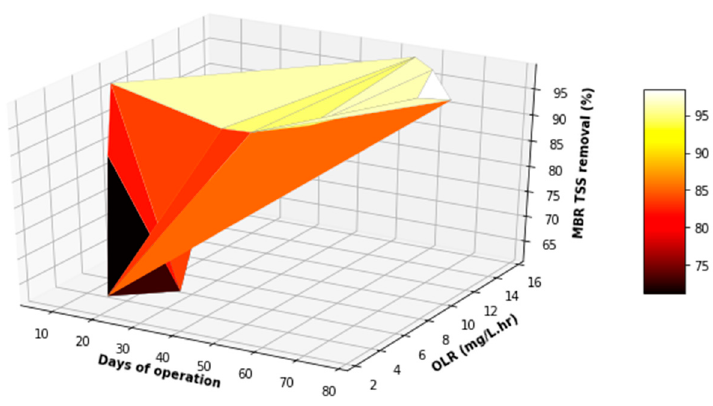
Figure 17. Variation in COD removal with varying OLR during the operation of the MBR.